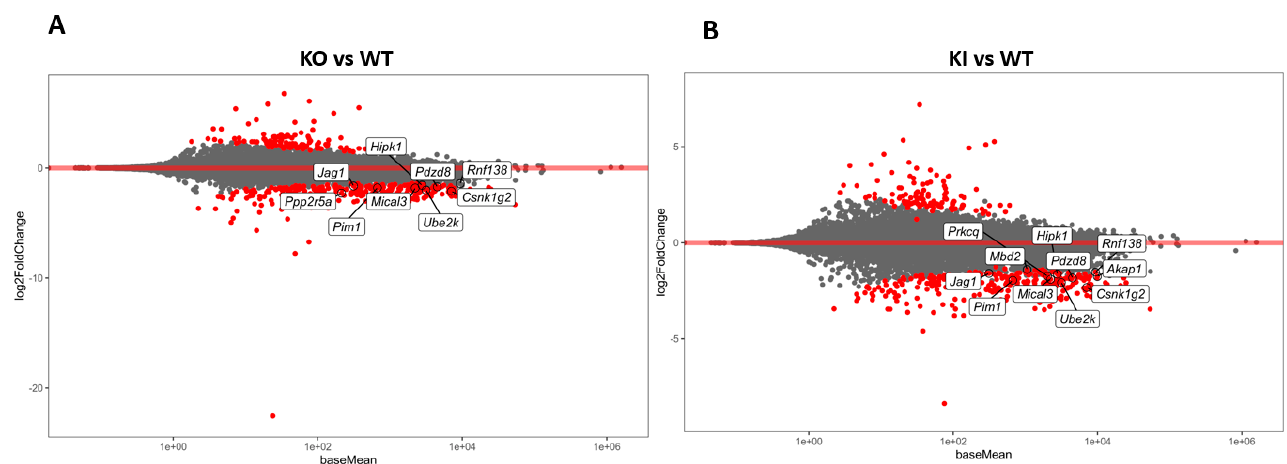
Figure 1. Transcriptome analysis of RS from KO, KI, and WT mice. ( A ) MA plot (log2 fold change vs. average of counts) shows differentially expressed genes (DEGs) from KO and WT ( B ) MA plot (log2 fold change vs. average of counts) shows DEGs from KI and WT groups. The red dots indicate the significantly ( p < 0.1) upregulated or downregulated genes in each of RS of KO or KI compared to WT.